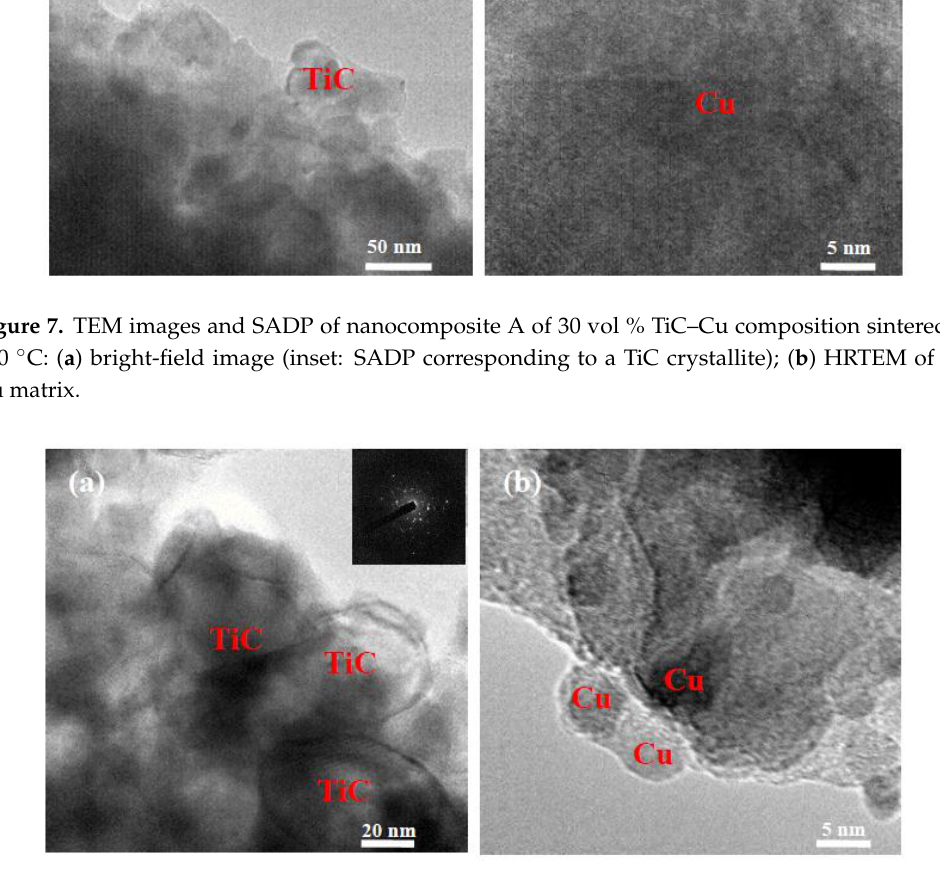
Figure 8. TEM images and SADP of nanocomposite B of 20 vol % TiC–Cu composition sintered at 900°C: ( a ) bright-field image (inset: SADP corresponding to a TiC crystallite); ( b ) HRTEM of the Cu matrix.